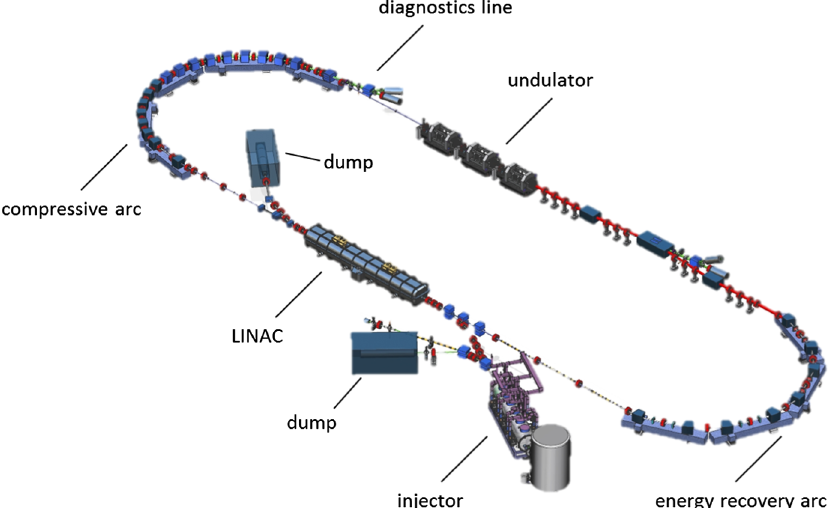
FIG. 1. Conceptual scheme of an ERL-FEL; beam moves clockwise. The scheme is not to scale, and a portion of the straight lines is omitted in order to make the arc lattice more evident.